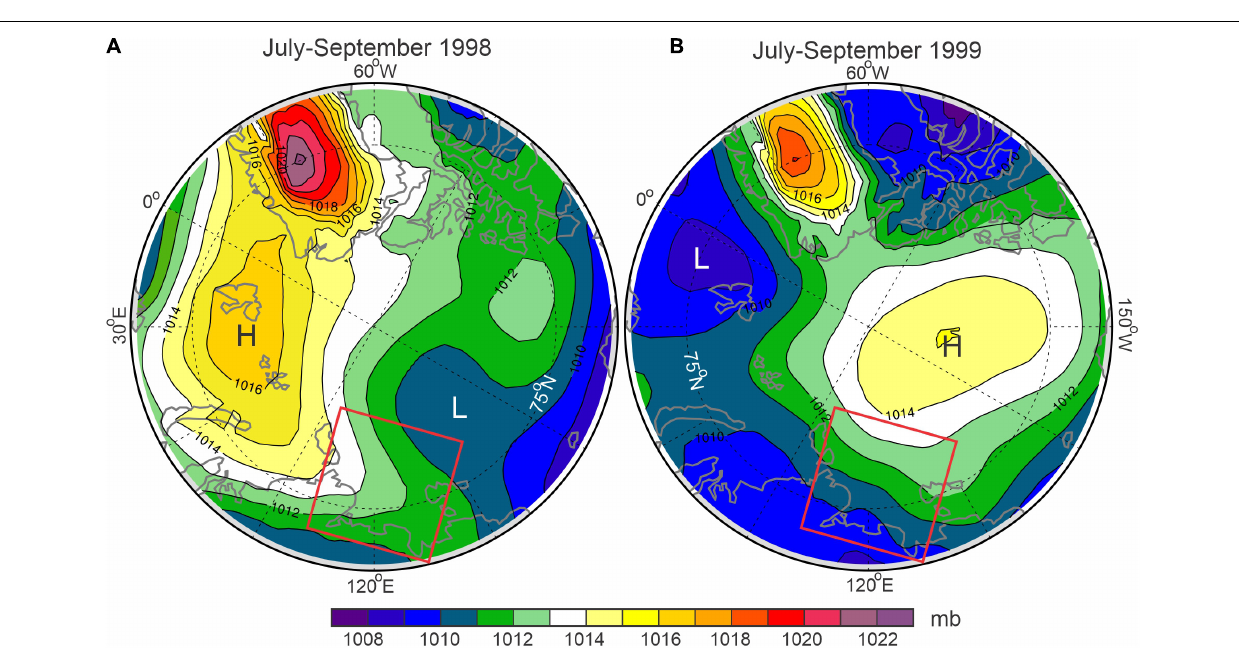
Frontiers in Marine Science |